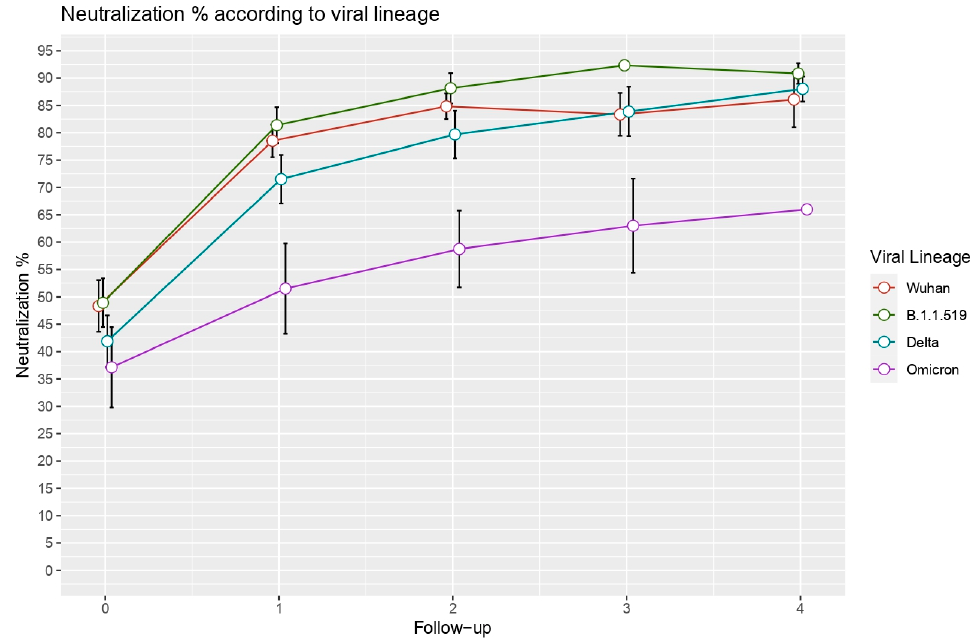
Figure 5. Longitudinal measurement of neutralizing antibodies according to viral lineage. Each point represents the median neutralization value with standard error for that follow-up measurement. Wuhan-like lineages are represented by the orange line, the green line represents patients infected with lineage B.1.1.519, the blue line represents patients infected with VOC Delta, and the purple line represents patients infected with Omicron.